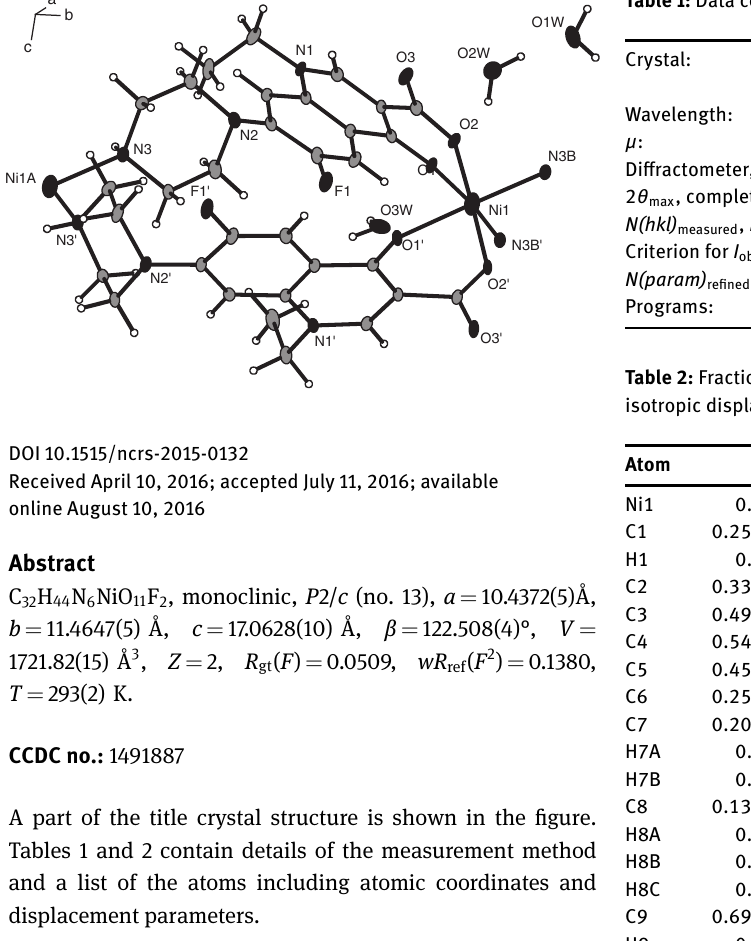
Table 1: Data collection and handling.